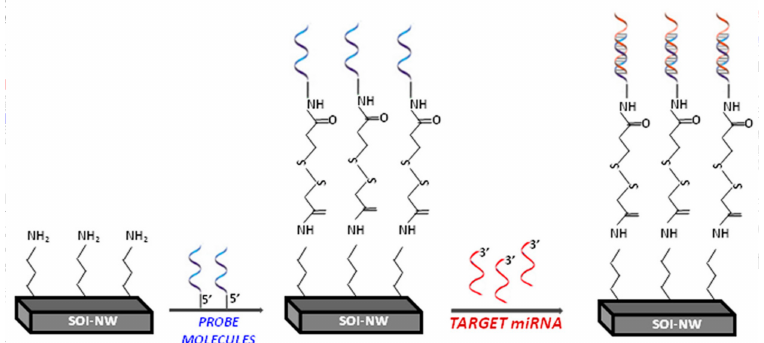
Figure 1. Schematic illustrating the detection of miRNA with the silicon-on-insulator nanowire ((h-k)-SOI-NW)